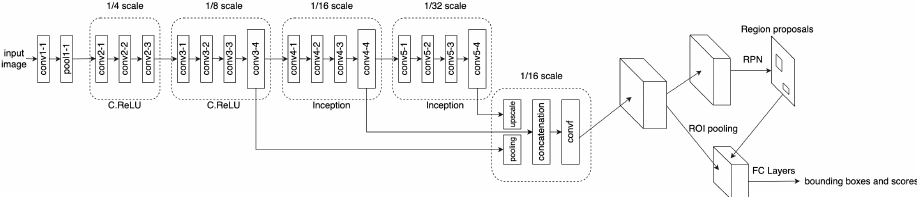
Figure 3. The structure of PVANET.